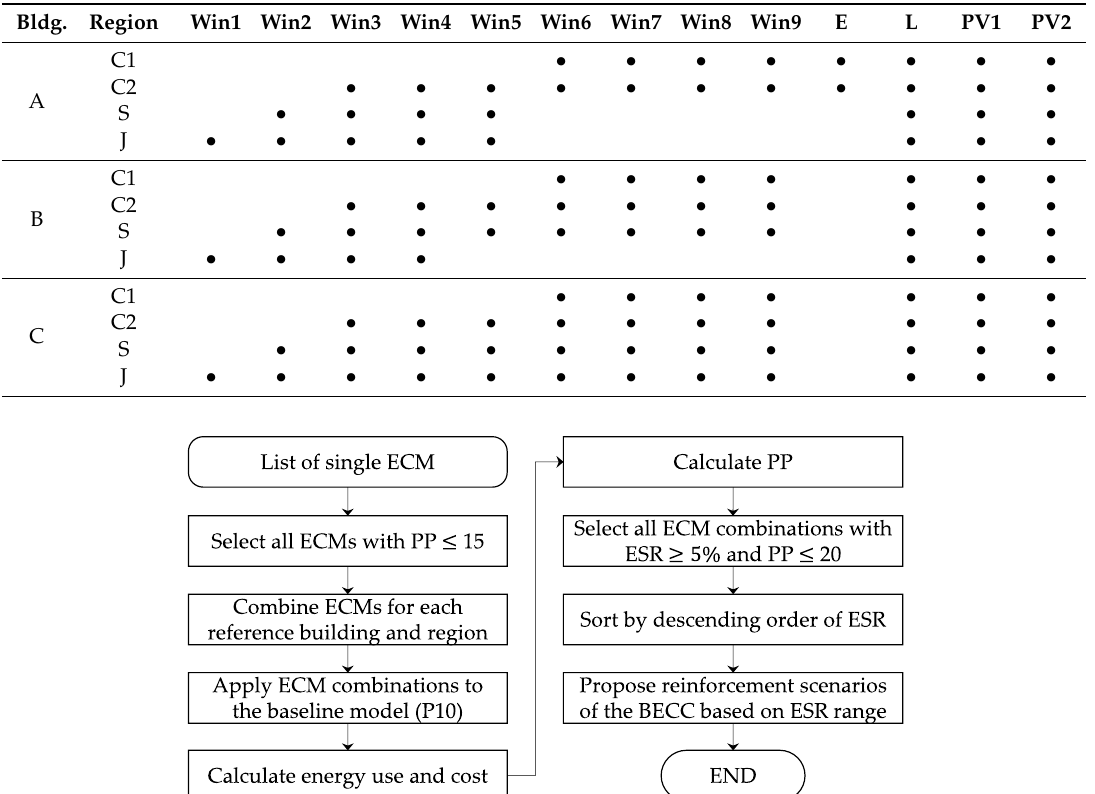
Table 14. The selected ECMs for each reference building and region.